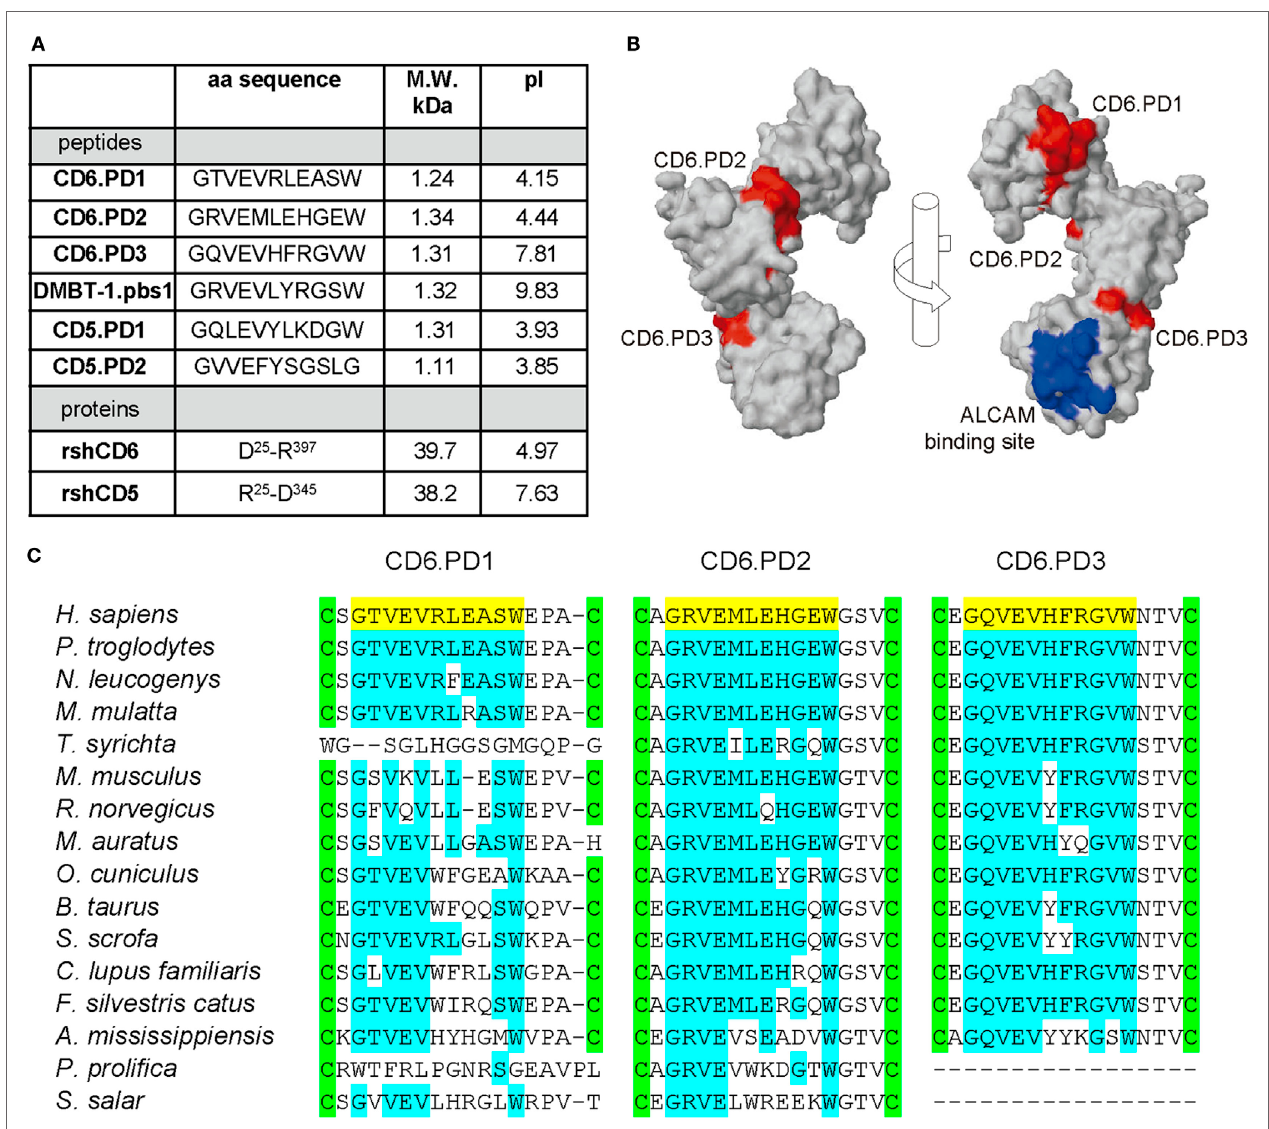
FigUre 1 | Structural characteristics of the peptides and proteins from the scavenger receptor cysteine-rich superfamily (SRCR-SF) members in the study. (a) Amino acid sequence, molecular weight (M.W.) and isoelectric point (pI) of the CD5, CD6, and deleted in malignant brain tumors-1 (DMBT-1) peptides and proteins analyzed in this study. (B) Three-dimensional surface representations of the extracellular region of human CD6 (PDB identifier 5a2e, visualized with Jmol) displaying the relative position of the CD6 peptides in the study (colored red) and amino acids involved in binding to the CD6 ligand, CD166/activated leukocyte cell adhesion molecule (ALCAM) (colored blue). (c) Alignment of the SRCR domain 1, 2, and 3 amino acid sequences of CD6 from primate ( Homo sapiens , accession number P30203; Pan troglodytes , H2Q3T6; Nomascus leucogenys , G1RTX7; Macaca mulatta , H9ZFC2; and Tarsius syrichta , A0A1U7SL56) rodent ( Mus musculus , Q61003; Rattus norvegicus , Q812A4; and Mesocricetus auratus , A0A1U8BJ49), lagomorph ( Oryctolagus cuniculus , G1T3D3), artiodactyl ( Bos taurus , F1MU15; Sus scrofa , K7GS39), carnivoran ( Canis lupus familiaris , F1PV91; Felis silvestris catus , M3WJ99), crocodilian ( Alligator mississippiensis , A0A151NXS4), and fish ( Poeciliopsis prolifica , A0A0S7G288; Salmo salar , A0A1S3RVR2) species, where the peptides in study (colored yellow) map. Conserved intradomain cysteine residues and amino acid identities are highlighted in green and blue,